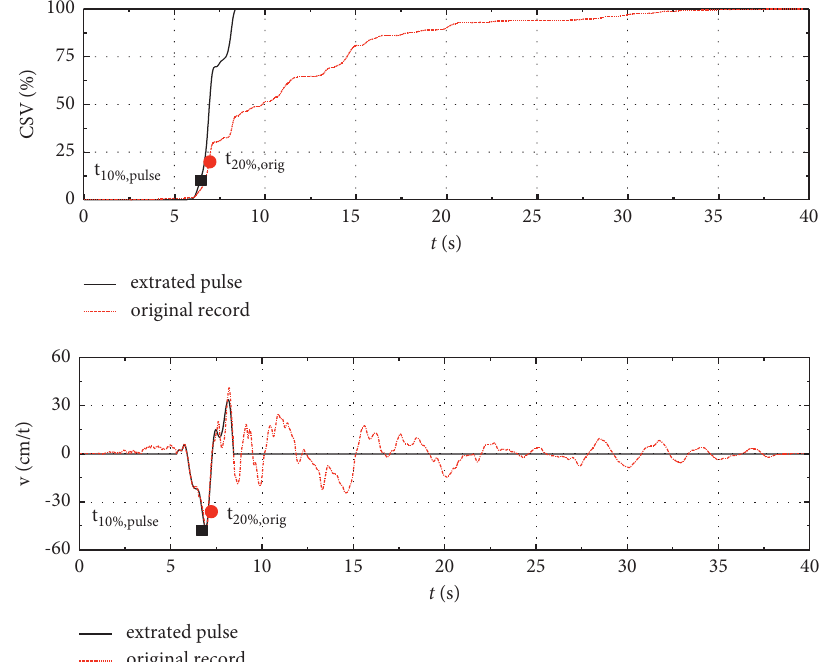
Figure 10: The square velocity accumulated.